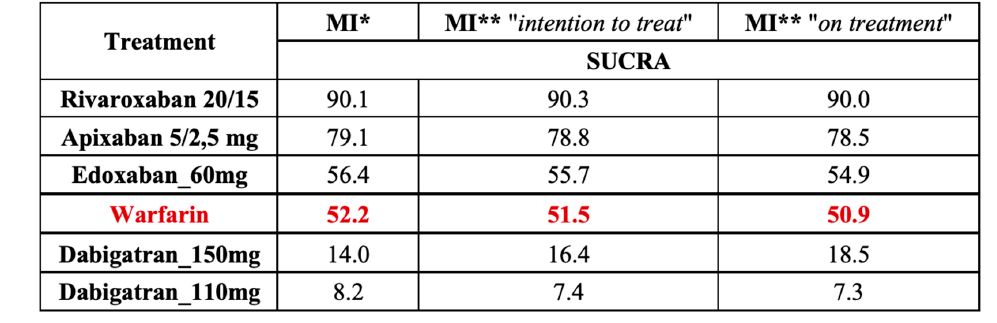
Figure 6. The surface under the cumulative ranking curve ( SUCRA ) of myocardial infarction. * original data from RE-LY study [23]; ** results from reanalysis RE-LY study [27] . The red numbers refer to warfarin as the comparator for all investigated drugs.